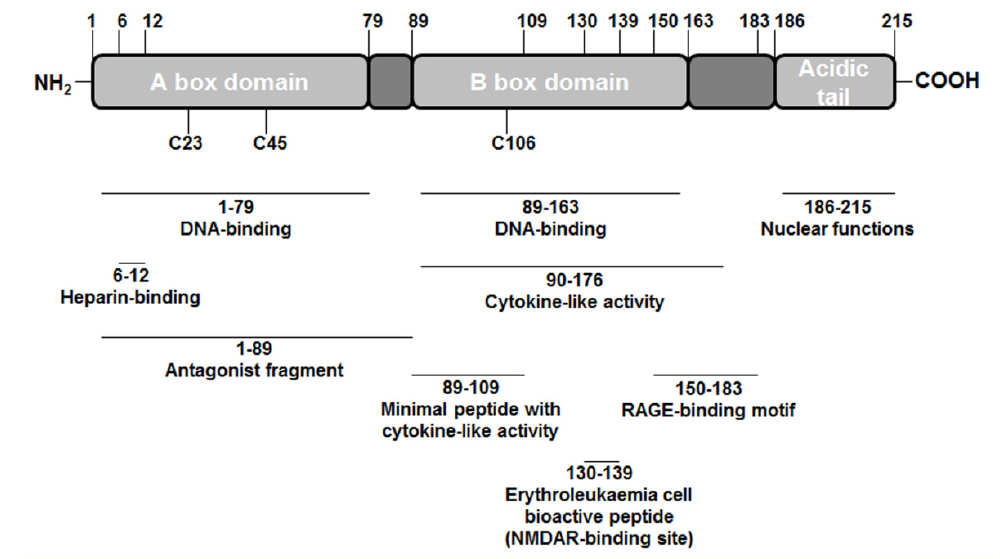
Figure 1. Scheme of high-mobility group box 1 (HMGB1)